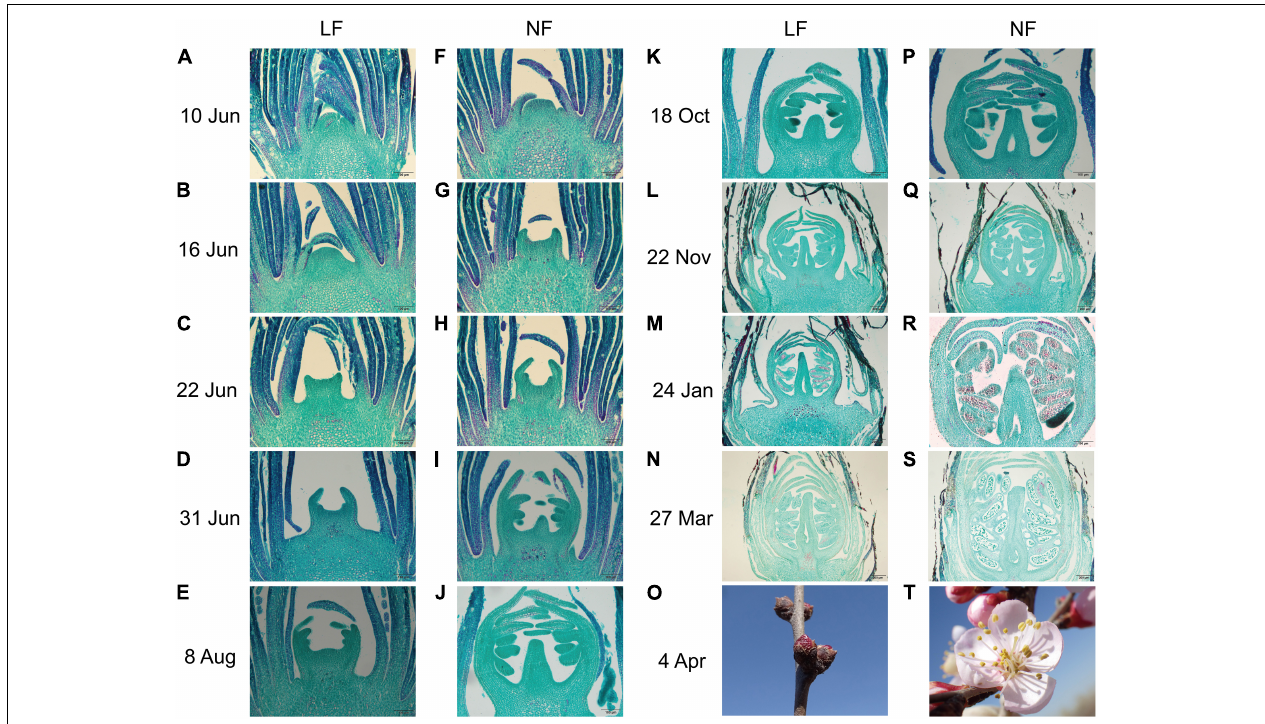
FIGURE 1 | Comparison of the flower bud differentiation process between (A–E,K–O) LF and (F–J,P–T) NF in P. sibirica. (A) Undifferentiated stage with buds in the leaf bud state; the growth point is small and tightly wrapped in layers of bud scales. (B,F) Initial differentiation stage with the top of the growth point bulges gradually and the bud scales become loose. (C,G) Calyx differentiation stage with calyx primordia gradually becoming elongate and bent inward. (D,H) Petal differentiation stage with petal primordium as a small second lobe at the bottom of the calyx primordium, wrapped in the calyx primordium and elongate with the calyx primordium. (E,I) Stamen differentiation stage with stamen primordium as the third lobe inside, forming a number of protuberances. (J,K) Pistil differentiation stage with pistil primordium bulges in the middle of the bottom and continued elongation. (L,P) Initiation of ovary and differentiation of sporogenous tissue. (M,Q) Initiation of ovule and formation of microspore mother cell. (N,R) Differentiation of ovule. (S) Formation of pollen grain. (O) Flower bud of LF. (T) Bloom of NF.